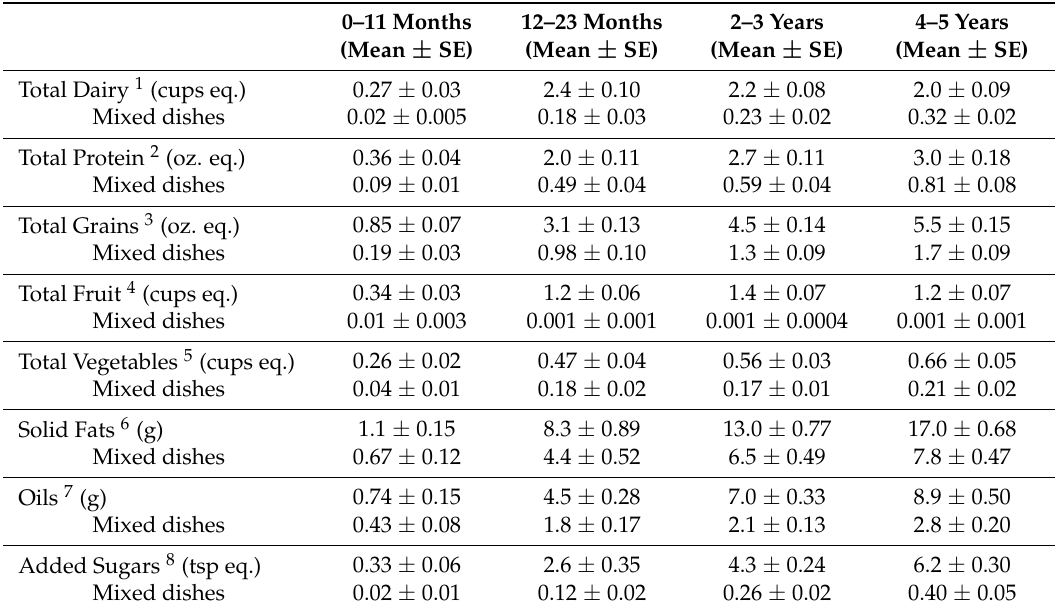
Table 2. Amount of food consumed per food group, NHANES